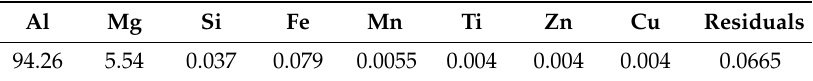
Table 1. Chemical composition of AlMg5 alloy